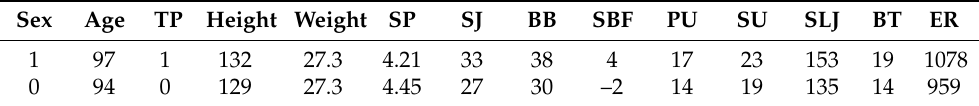
Table 1. An example of test data